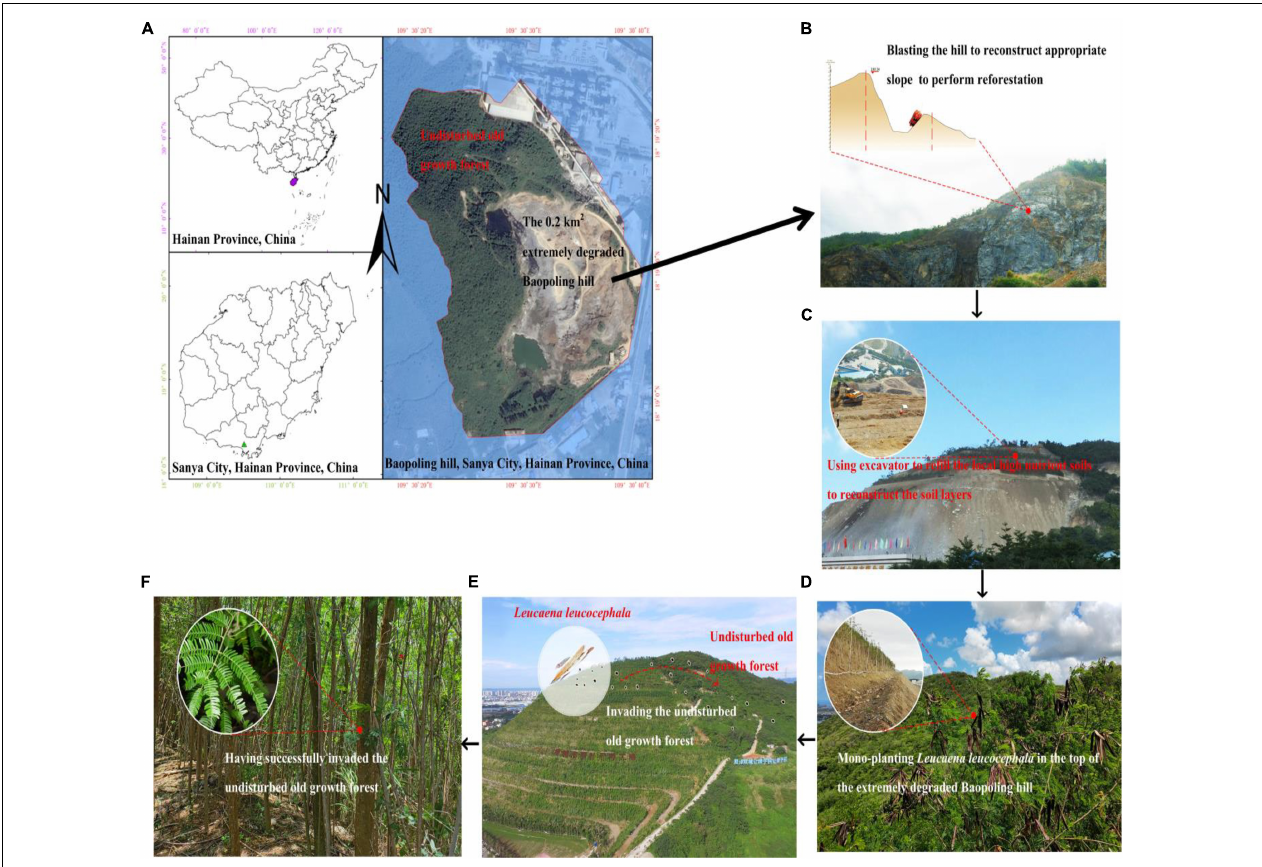
FIGURE 1 | Map of the study site (Baopoling hill) and the surrounding landscape, including the 0.2 km 2 area of extremely degraded land and the undisturbed old growth forest (A) and the detail processes for describing why and how Leucaena leucocephala not only becomes highly invasive in Baopoling hill, but also has successfully invaded the undisturbed old growth forest (B–F)